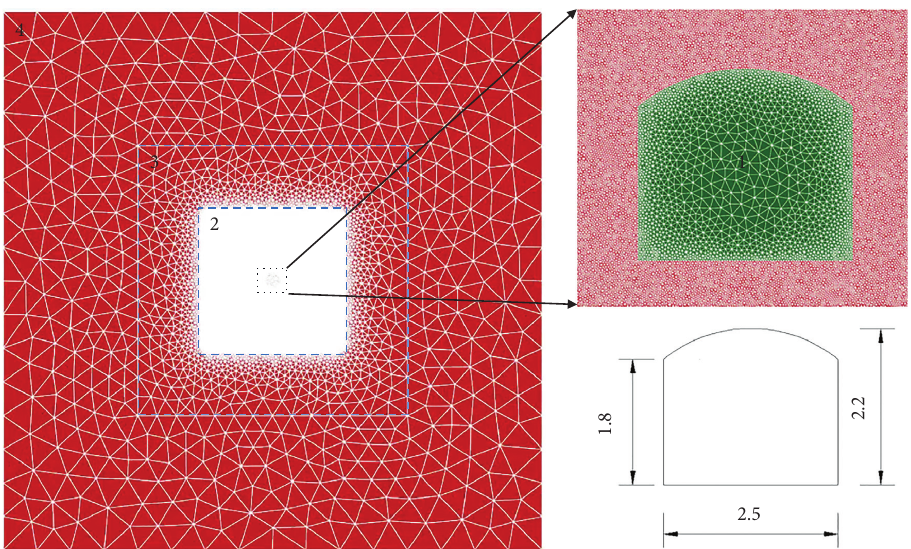
Figure 5: Model of numerical simulation. Table 1: Microparameters for simulation.